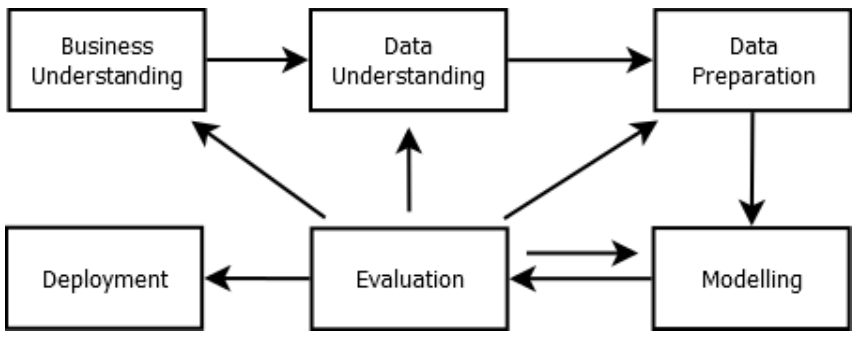
Figure 3. Schematic depiction of data mining according to CRISP-DM.